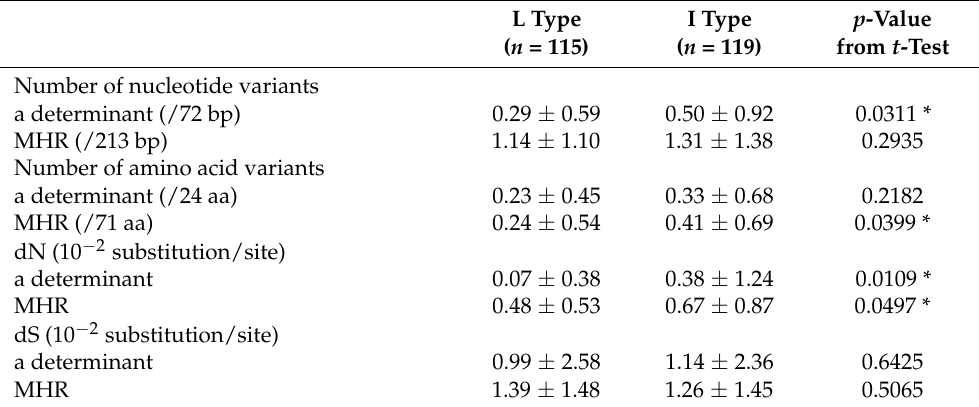
Table 2. Comparison of genetic diversity within MHR and “a” determinant regions between rt269L and